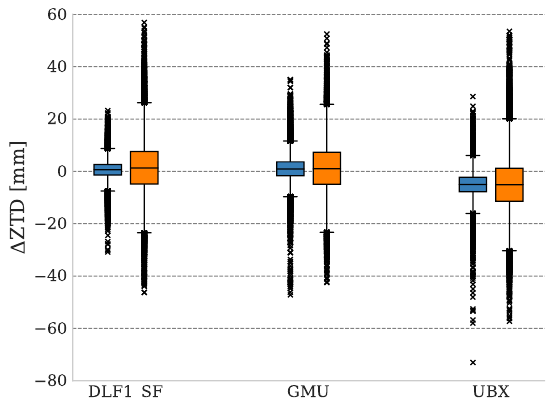
Figure 6. Boxplots of the SEID-single-frequency ZTD differences to the DLF1_DF reference using the DPGA SEID constellation (blue) and the EUREF reference stations